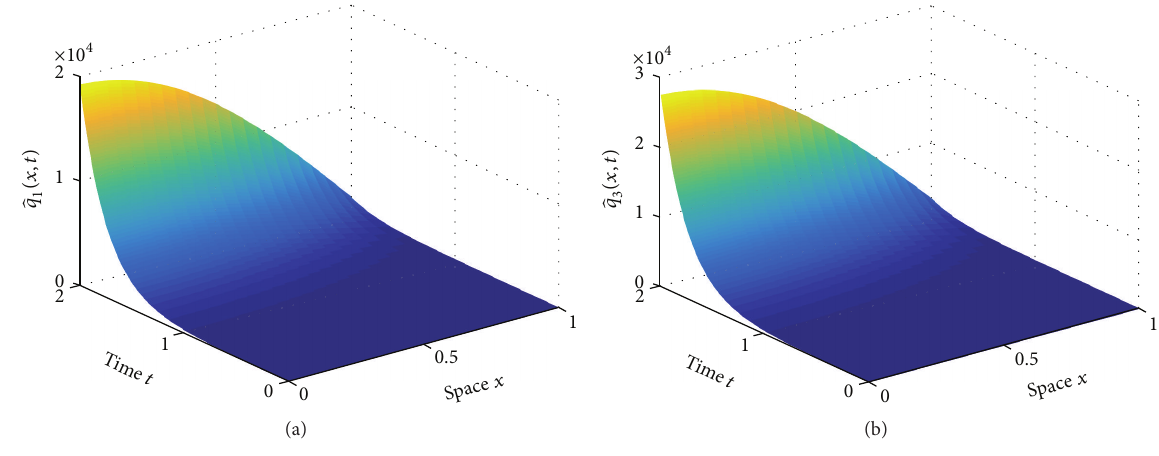
Figure 2: Spatiotemporal evolution of ̂𝑞 1 (𝑥,𝑡) (a) and ̂𝑞 3 (𝑥,𝑡) (b).